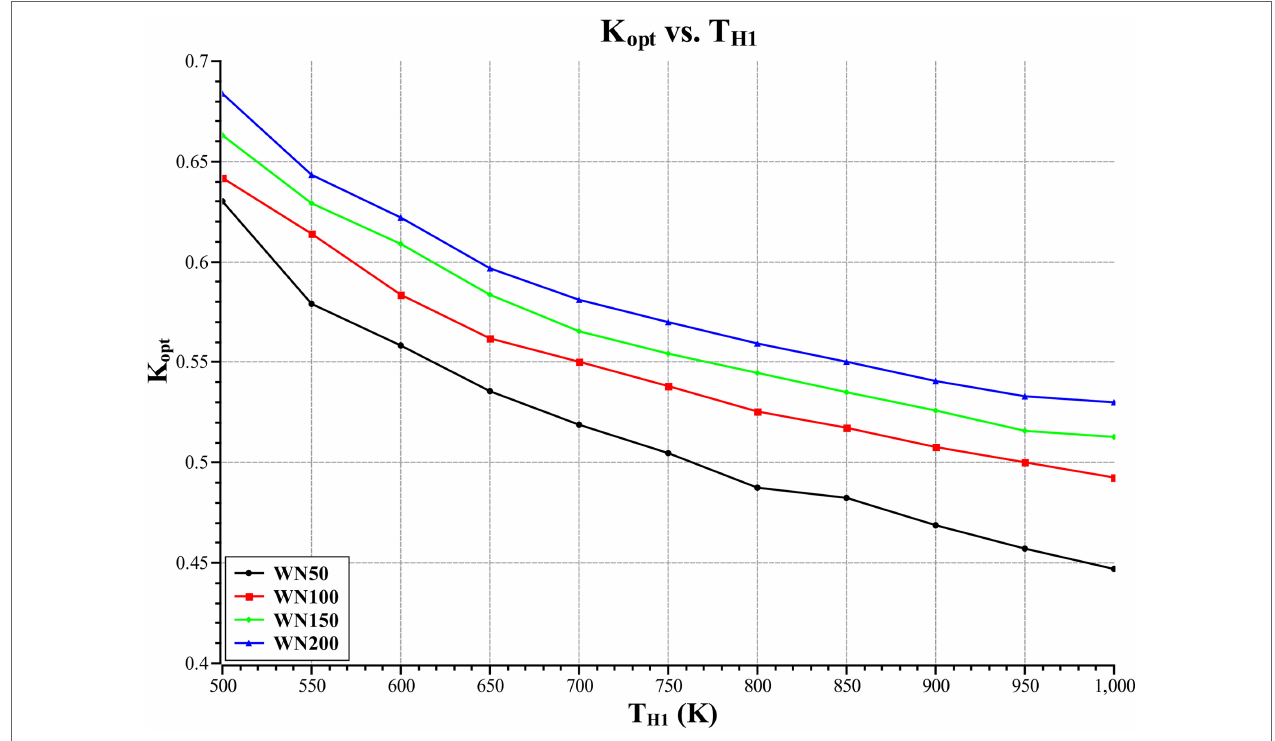
FIGURE 5 | Optimal dead-volume ratio versus heater inlet temperature.